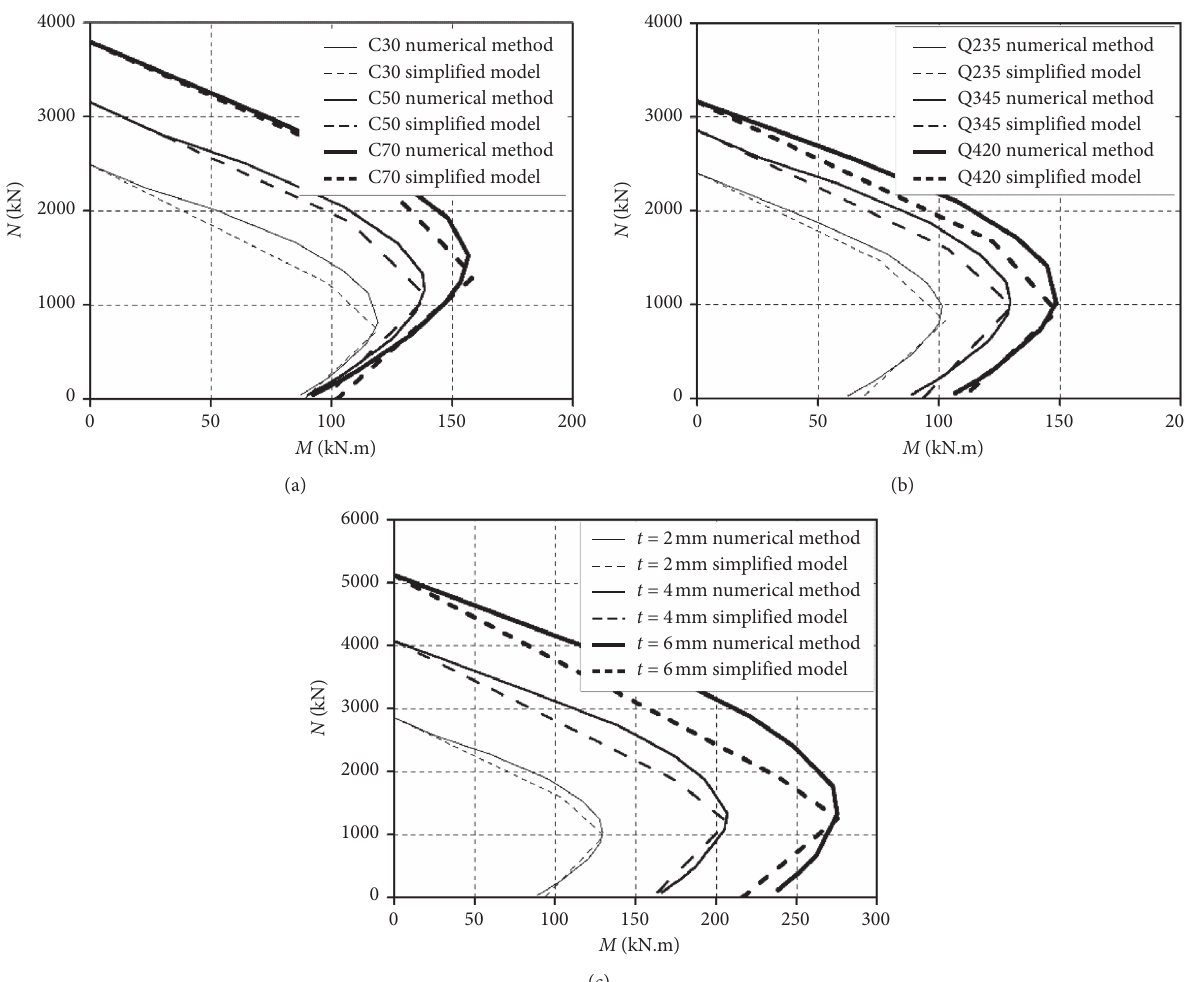
Figure 21: Verification of cross-sectional simplified N-M resistance model. (a) Concrete strength ( f ) tube thickness ( t ).